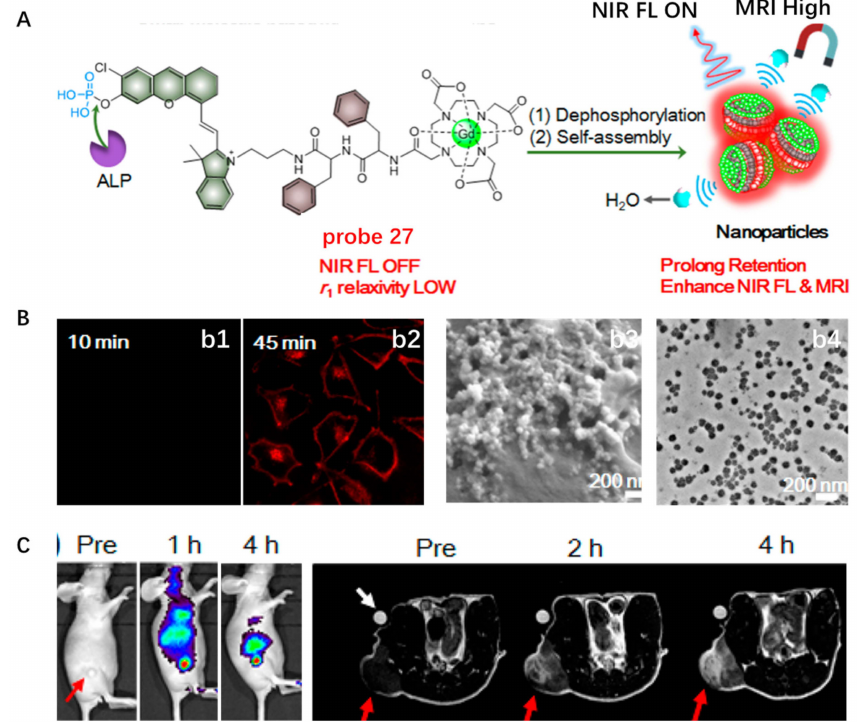
Figure 27. ( A ) Chemical structure of probe 27 and ALP-mediated in situ self-assembly into NPs. ( B ) NIR fluorescence im-aging of HeLa cells incubated with probe 27 (( b1 , b2 ), Scale bar: 25 µ m) and cryo-SEM image and TEM image of the self-assembled NPs on CM (( b3 , b4 ), Scale bar: 100 µ m.). ( C ) NIR fluorescence and MRI imaging of endogenous ALP in tumor. Copyright 2019 American Chemical Society